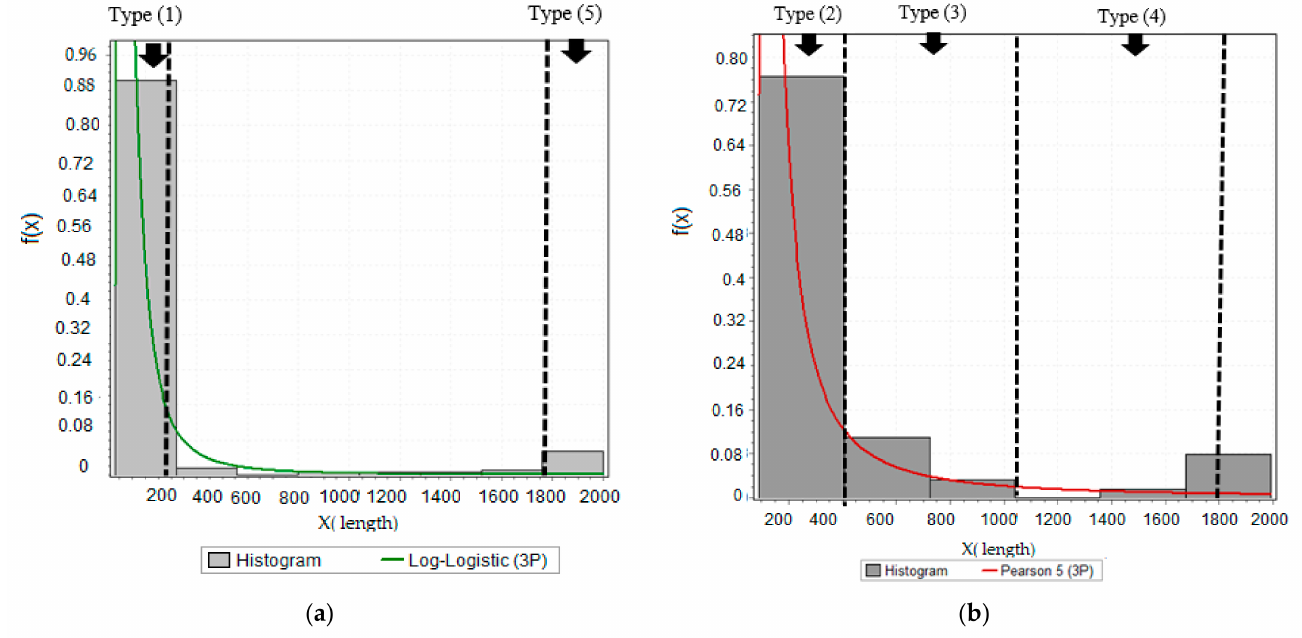
Figure 4. Histogram and a PDF for the processed IE signals collected from slab (2), ( a ) sound, ( b )